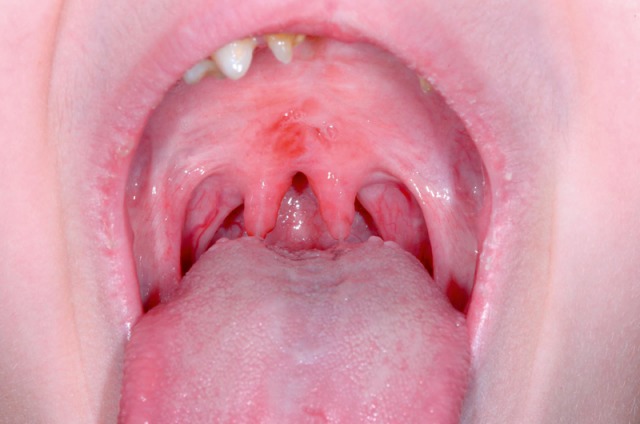
16-year-old patient suffering from Johanson-Blizzard syndrome. Incompletely treated cleft lip and palate and velopharyngeal insufficiency with passage of food and liquids into the nose.